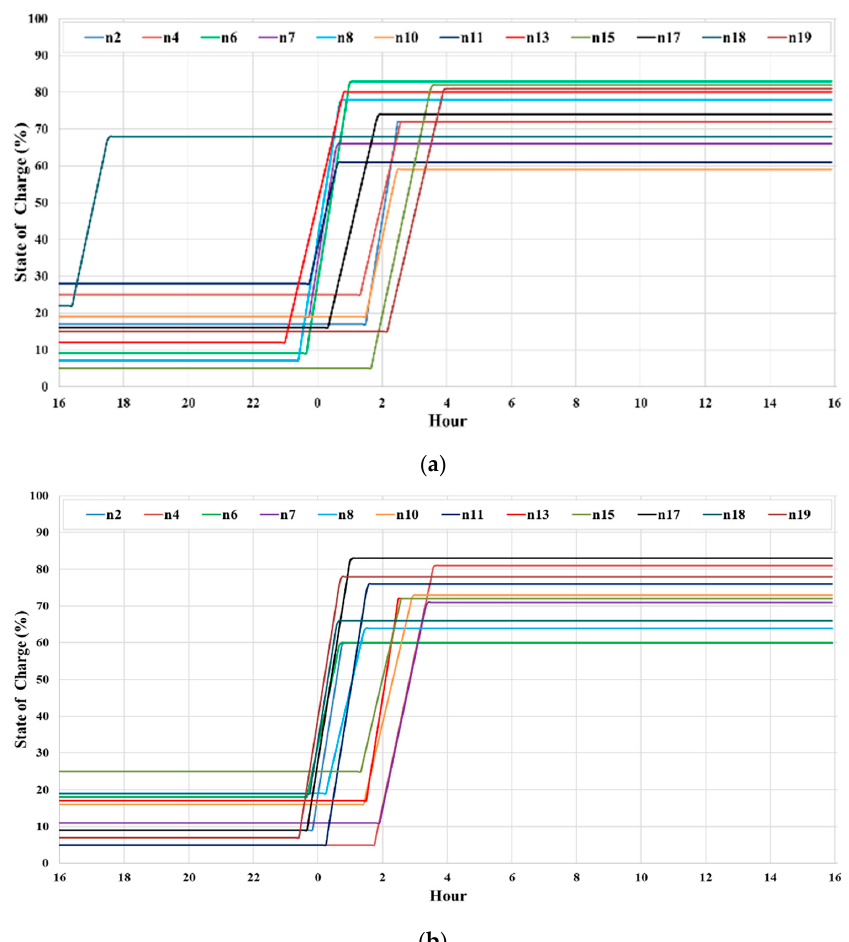
Figure 7. SOC for the weakest feeder for 63% penetration with capacitor switching and OLTC adjustment using ( a ) BPSO and ( b ) BGWO. Table 2. Technical impact of PEV charging in different scenarios on the distribution system.